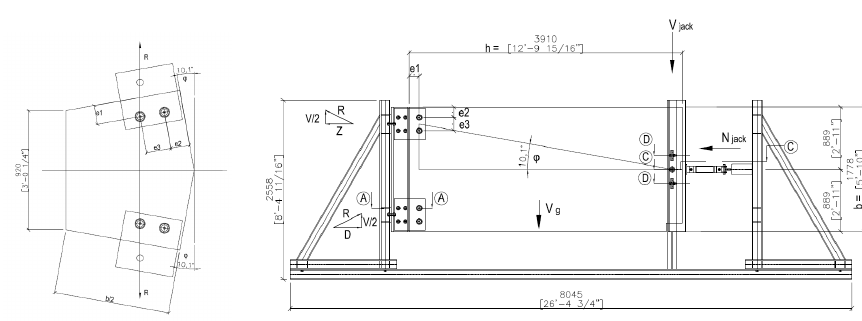
Figure 15: Test set up for the bottom connection tests (left) and the full scale tests